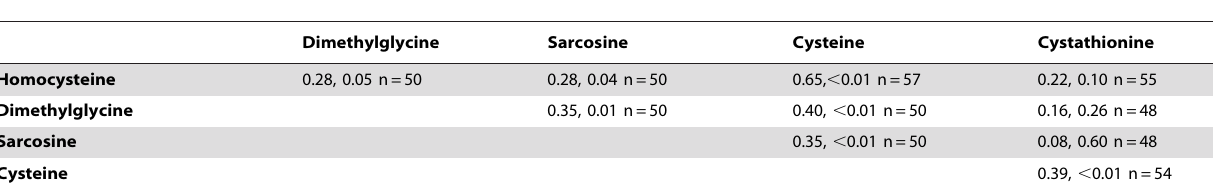
Table 4. Correlations among serum